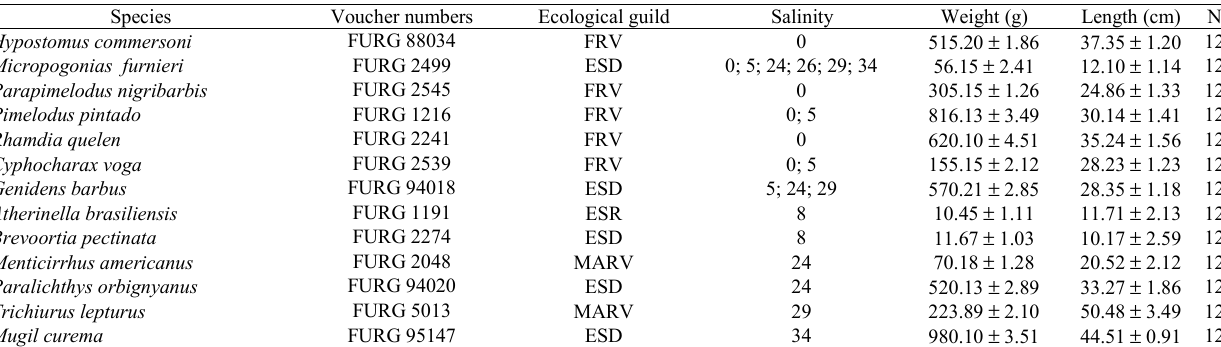
Table 1. Freshwater and marine/estuarine teleosts collected from water at different salinities from the São Gonçalo channel. Specimens were classified according to ecological guild: ESR: estuarine residents; ESD: estuarine dependents (diadromous); MARV: marine vagrants and FRV: freshwater vagrants (Vieira et al. , 1998; Garcia et al. , 2003a). Values are presented as the means ± SEM.